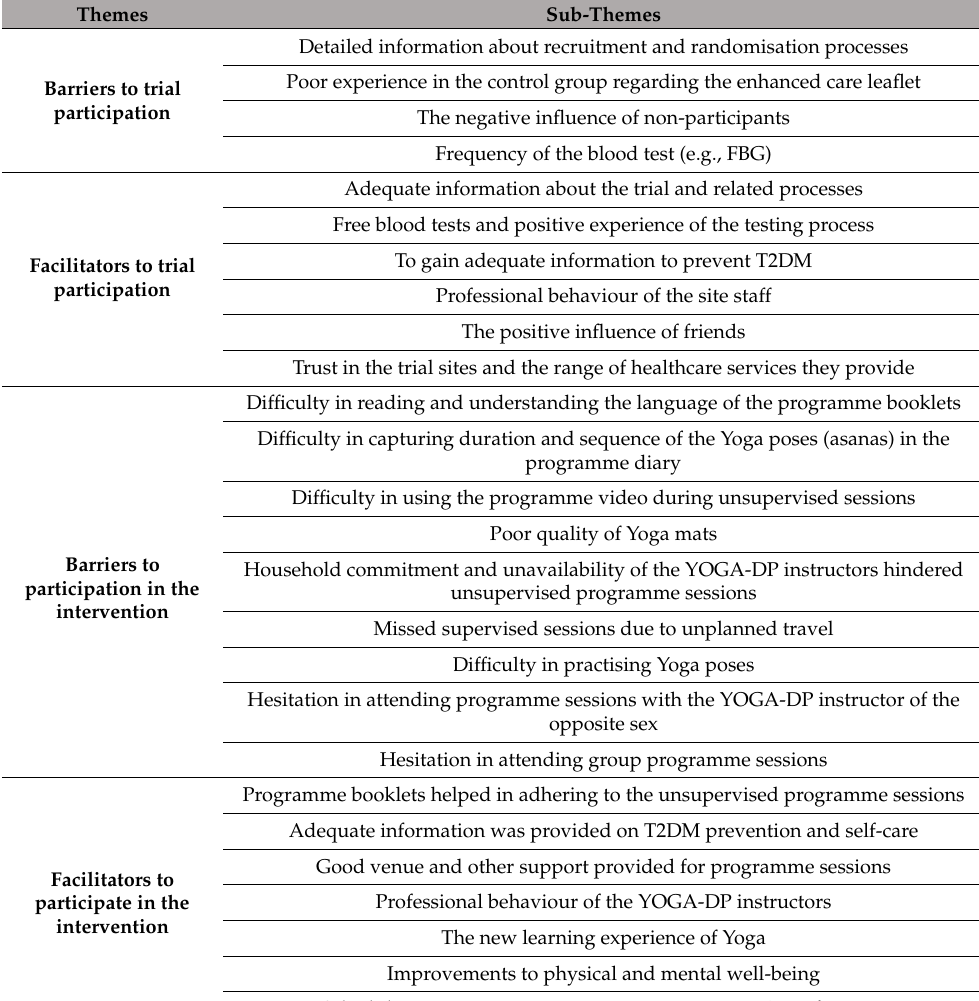
Table 2. Themes and